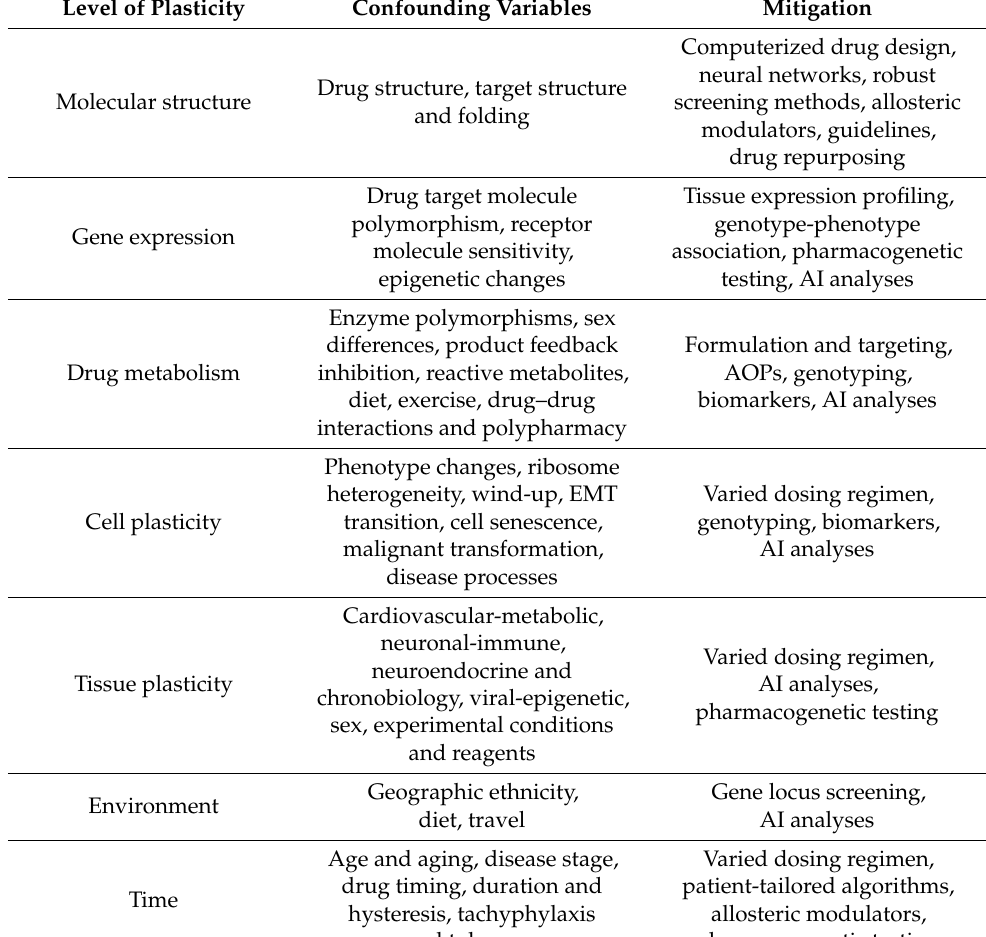
Table 1. Confounding variables which lead to plasticity of drug